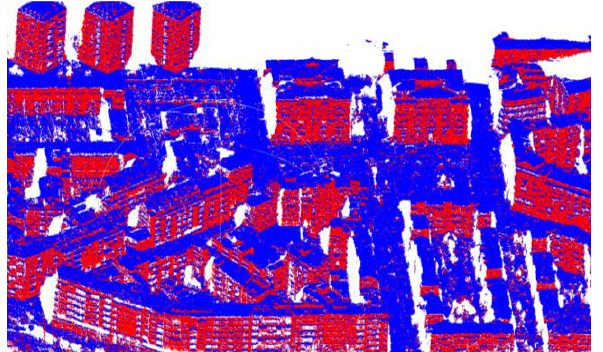
Figure 5. Segmentation of a dense point clouds in vertical (red) and horizontal (points) points.